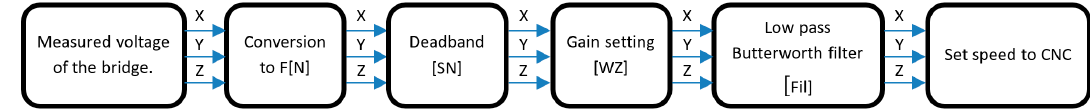
0 Figure 6. Signals at different stages of the processing algorithm (SN = 2N, WZ = 400, Fil: 4 Hz). First, the force with which the operator interacts with the lever is calculated as a function of the measured voltage and previous calibration. Another process consists in using a zone of insensitivity to eliminate components of measurement signals with val- ues oscillating around zero, resulting in a continuous pre-setting of movement sense tar- get variables (moments on the motor). The application of this procedure makes it easier to move the table along one axis of the table’s cruciform system, because when moving along one selected axis there are always low signal components from the perpendicular axis, which are cut out by the insensitivity zone. The advantage of this solution is easier